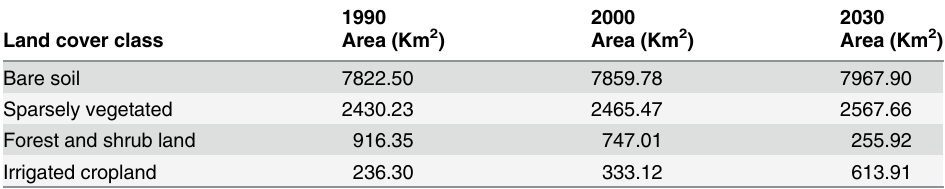
Table 4. The extent of land cover distribution in 1990, 2000 and the predicted cover in 2030.